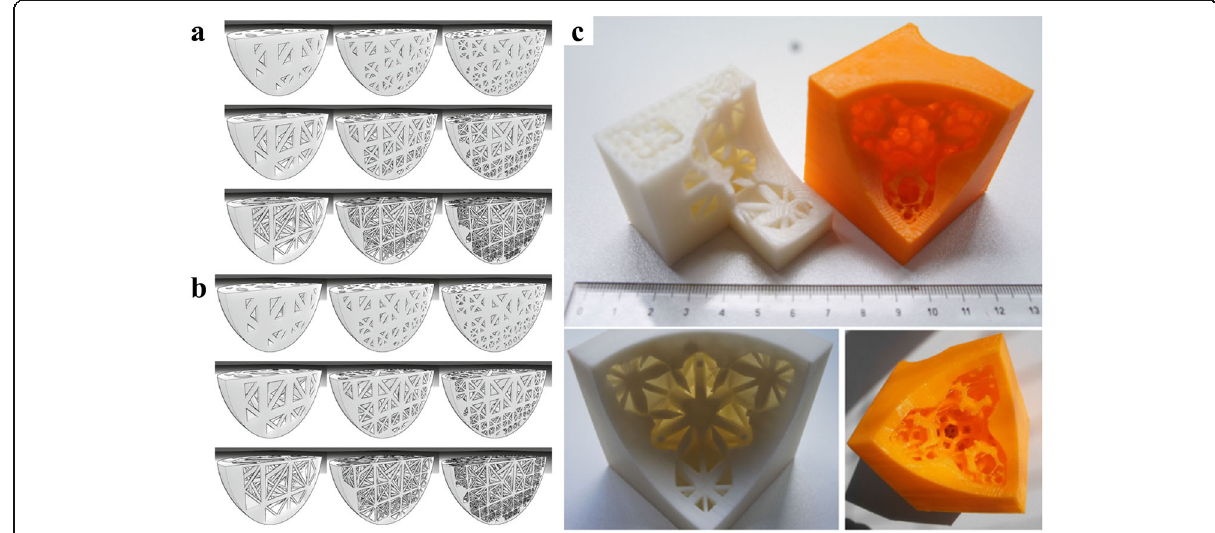
Fig. 4 Lightweighting structures: a Primal cellular structures. b Dual cellular structures. c Manufacturing results